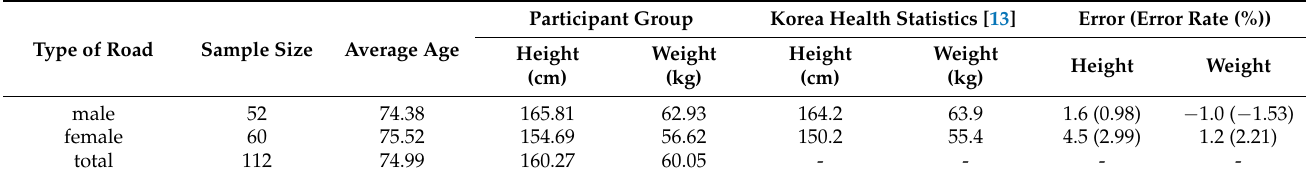
Table 3. Average body size of the elderly.